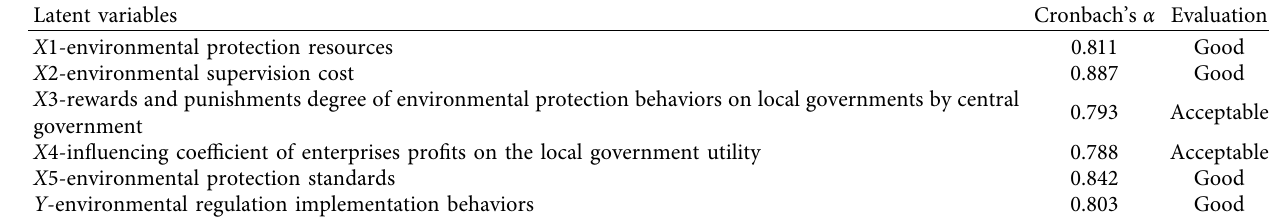
Table 4: Results of reliability test.